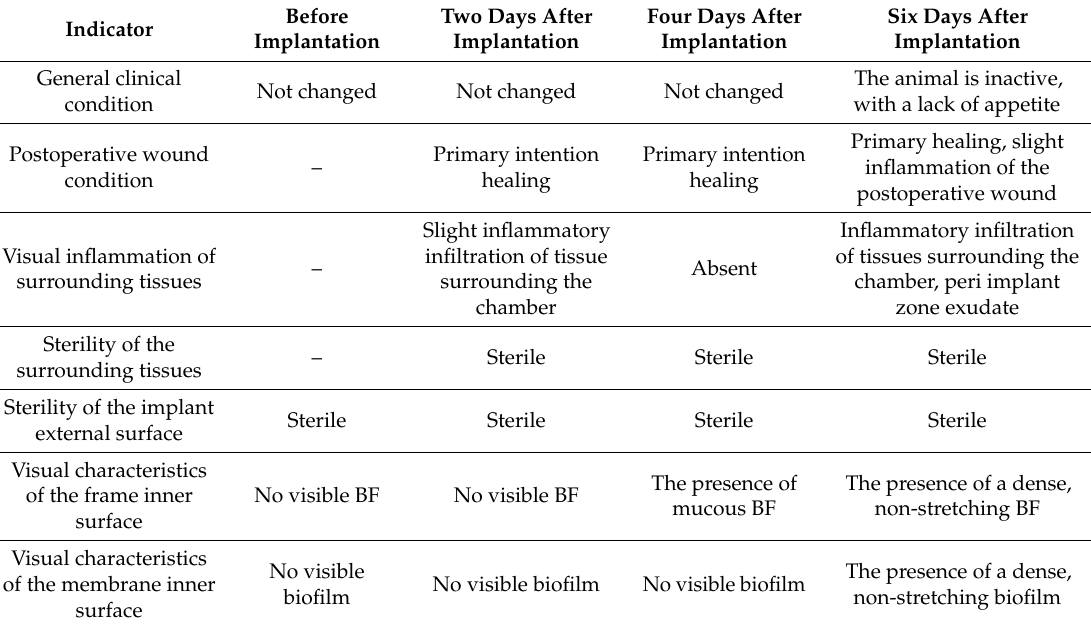
Table 1. Comparative characteristics of the K. pneumoniae Ts 141-14 biofilms formation in